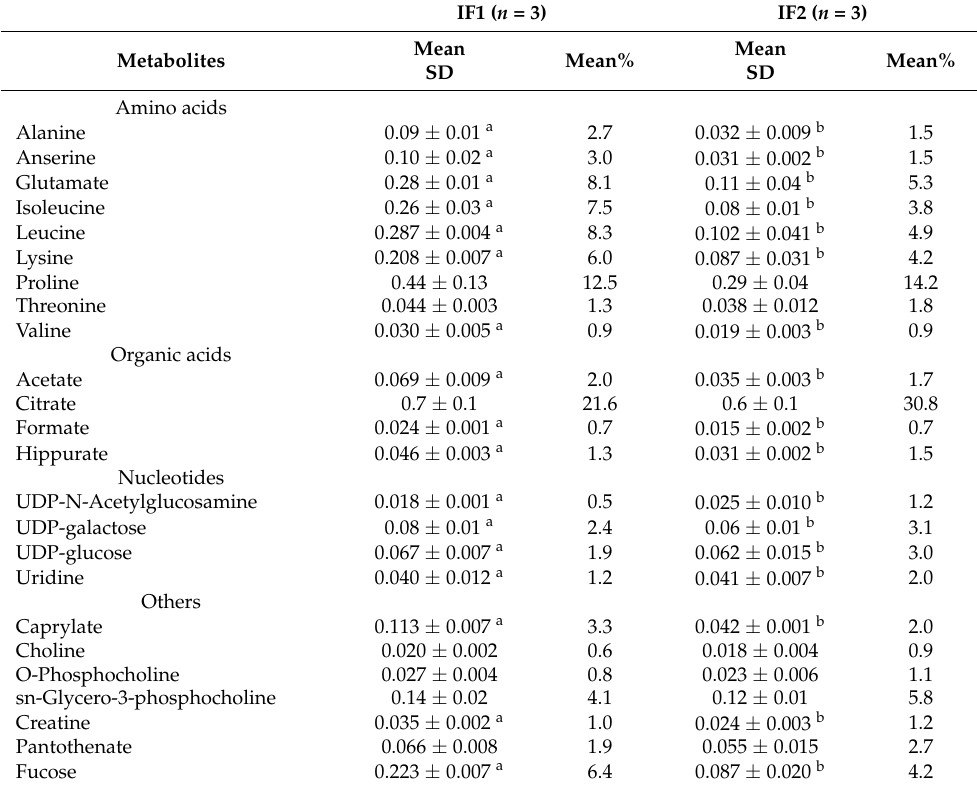
Table 6. NMR metabolite concentrations expressed in mM per 100 mL for liquid milk-derived formulations IF1 and IF2, to be used in the production of first stage (from 0 to 6 months of age) and follow-on (from 6 to 12 months of age) infant formulae,